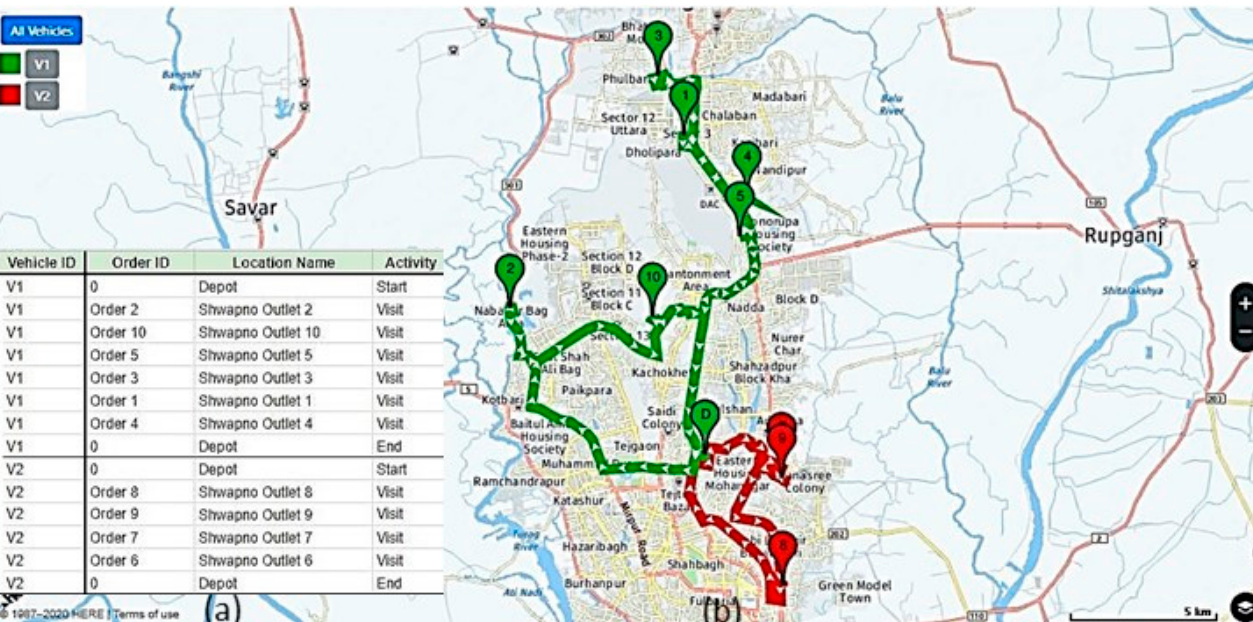
Figure 6. ( a ) Scheduling ( b ) Navigation sequencing of vehicle 1 and 2 for Region-1. For scheduling of vehicle 3 and vehicle 4 in Region-2, the latitude and longitude of outlet location information listed in Table 2 was added. Then, the vehicle capacity